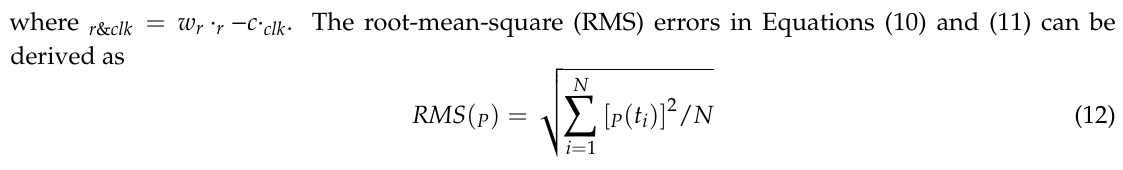
Table 2. Signal-in-space ranging error (SISRE) weight factors for statistical contribution of radial (R) as well as along-track (A) and cross-track (C) errors to the line-of-sight ranging error. System w r w 2 a , c GPS 0.98 1 / 49 GLONASS 0.98 1 / 45 Galileo 0.98 BDS(MEO) 0.98 BDS(GEO, IGSO) 0.99 1 /